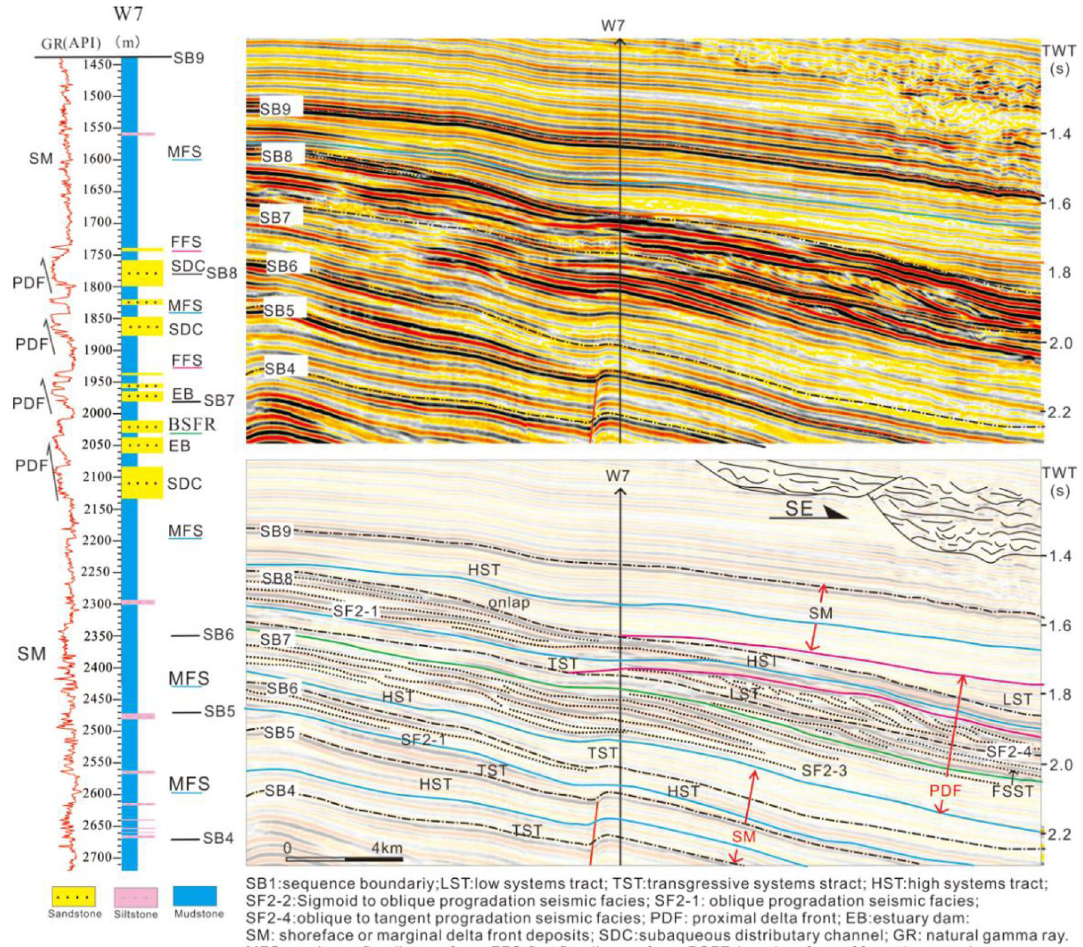
Figure 9. An interpreted seismic profile calibrated to borehole W7 demonstrating the deposits of the meandering river delta front from S4-S8 in the northwest of Baiyun Sag (see Fig. 1b for location of the profile). The proximal delta front deposits were located at the Highstand and Falling-stage systems tract of S6, the entire S7 and the Lowstand of S8, and exhibit characteristic thick bedded forests with upward-coarsening sand bodies (borehole W7 log